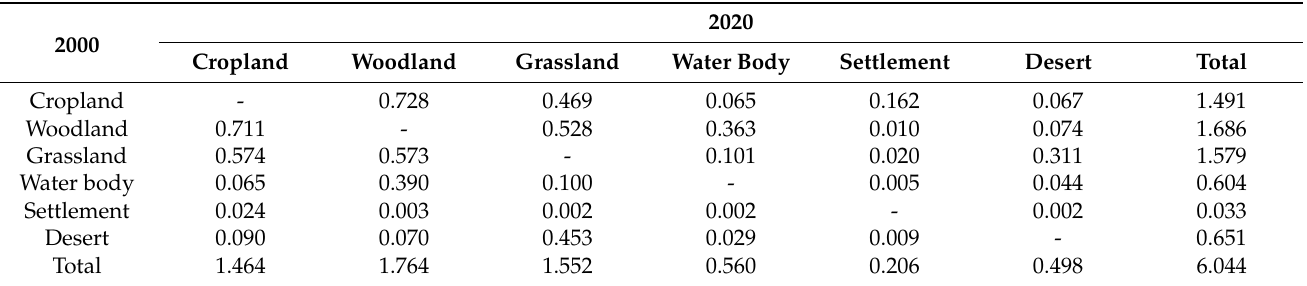
Table 7. Transfer matrix of different ecosystem areas in the Pan-Third Pole region from 2000 to 2020 (Unit: million km 2